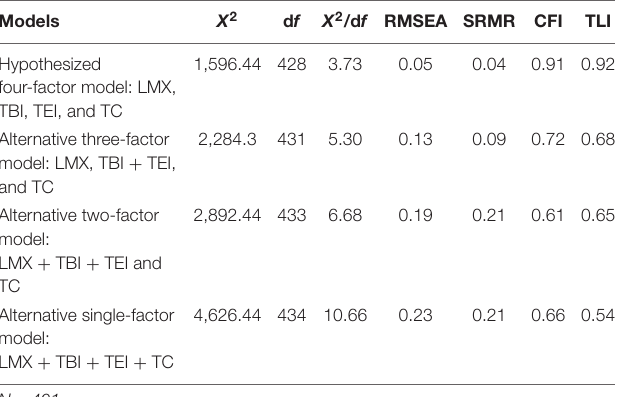
TABLE 1 | Comparison of measurement